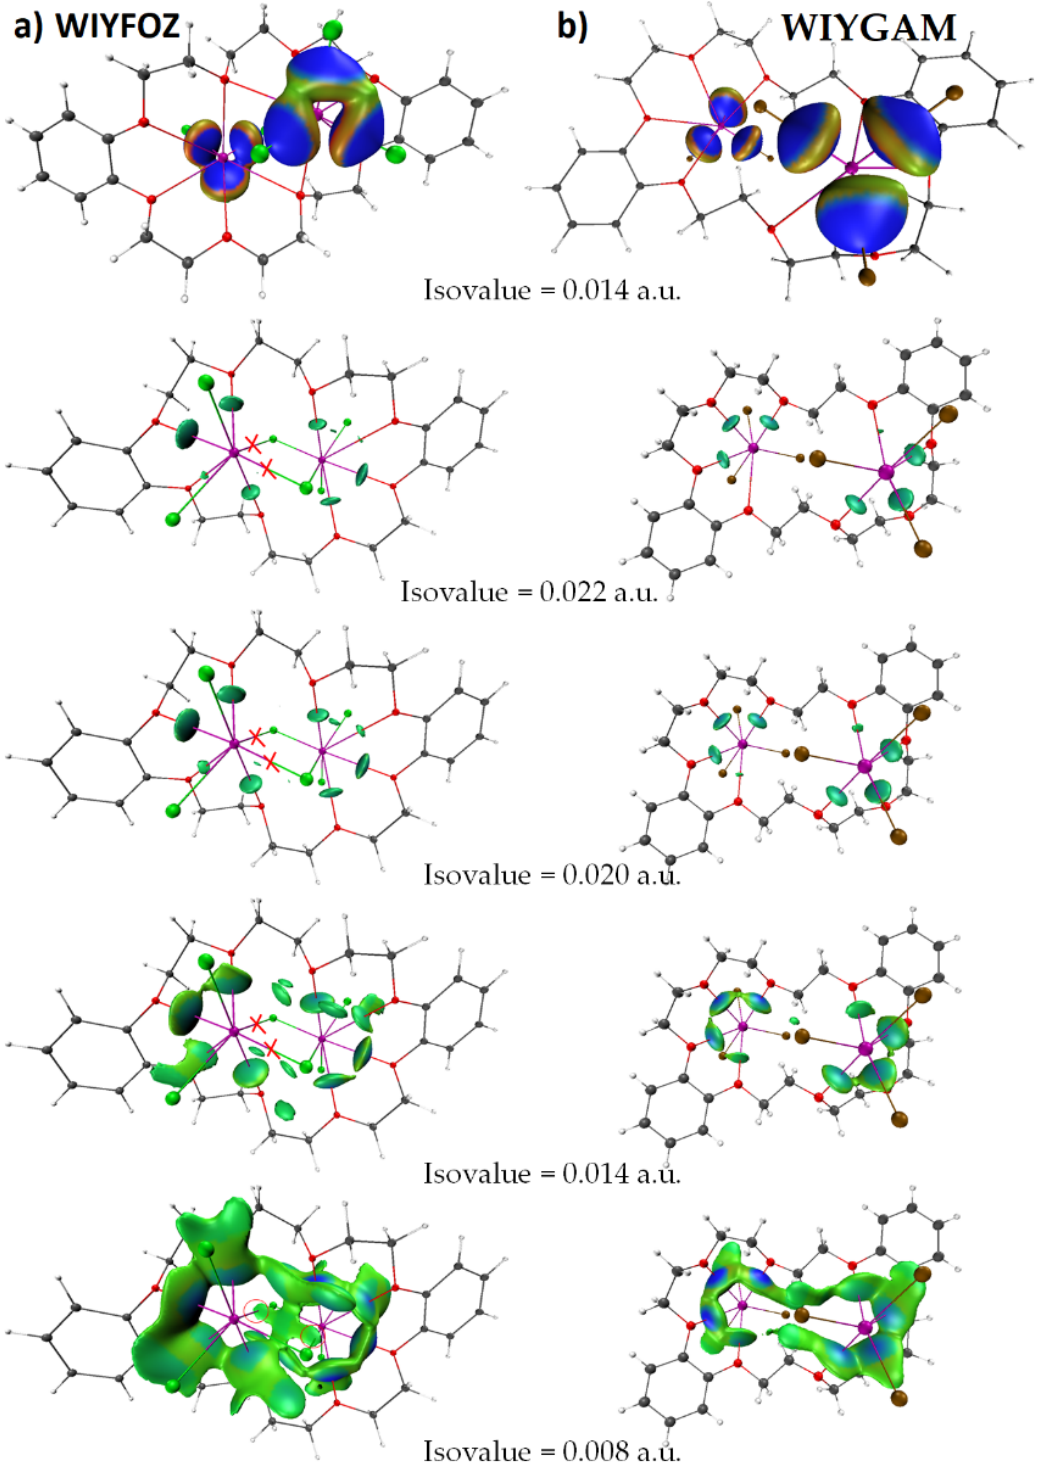
Figure 26. ( Top ) IGM- δ g based isosurface plots between Sb and X in SbX 3 : ( a ) (dibenzo-24-crown- 8)(SbCl 3 ) 2 and ( b ) (dibenzo-24-crown-8)(SbBr 3 ) 2 . ( Bottom ) IGM- δ g based isosurface plots between Sb and O in the corresponding systems, respectively, showing the dependence of the isosurfaces on the IGM isovalues. The crosses on the left plots indicate the disappearance of Sb ··· Cl bonds for high